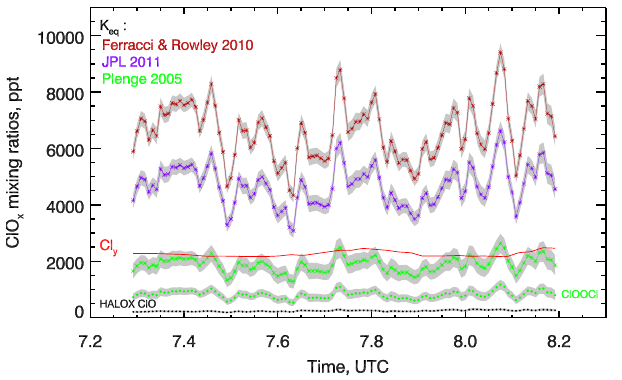
Fig. 7. ClO x mixing ratios derived from HALOX ClO night mea- surements (black circles) in combination with three chosen K eq . ClOOCl mixing ratios calculated with HALOX ClO and K eq from Plenge et al. (2005) are represented by green circles. Grey areas show the uncertainties propagated from the HALOX ClO observa- tions. The red line corresponds to Cl y calculated from the correla- tion with N 2 O (Eq. 3) measured by HAGAR.